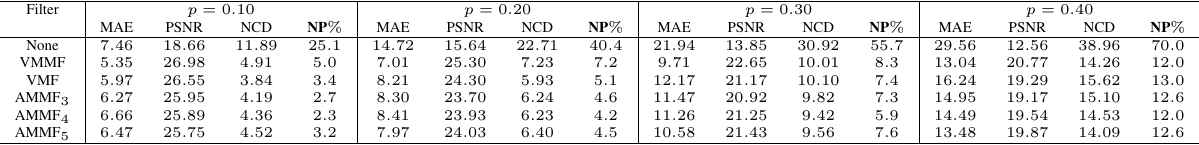
Table 3. Performance comparison in terms of MAE, PSNR, and NCD when filtering the Pills image contaminated with random-value impulse noise with probability p in each colour